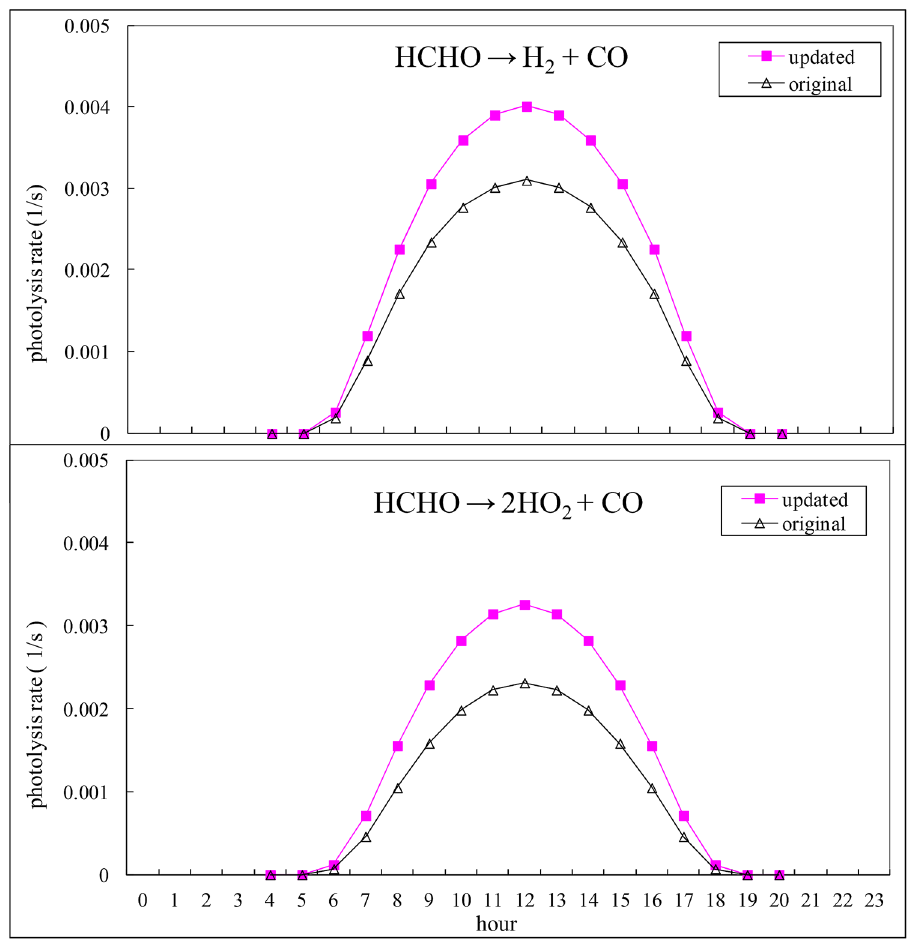
Figure 1. Comparison of the original and adjusted diurnal variations in the HCHO photolysis